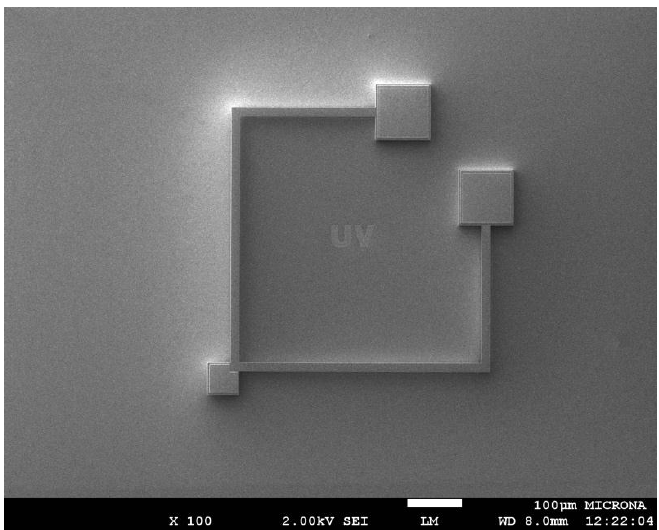
Figure 4. SEM image of magnetic field sensor composed by a polysilicon resonator, which is fabricated using a surface micromachining process. (Courtesy of A. L. Herrera-May, Universidad Veracruzana).